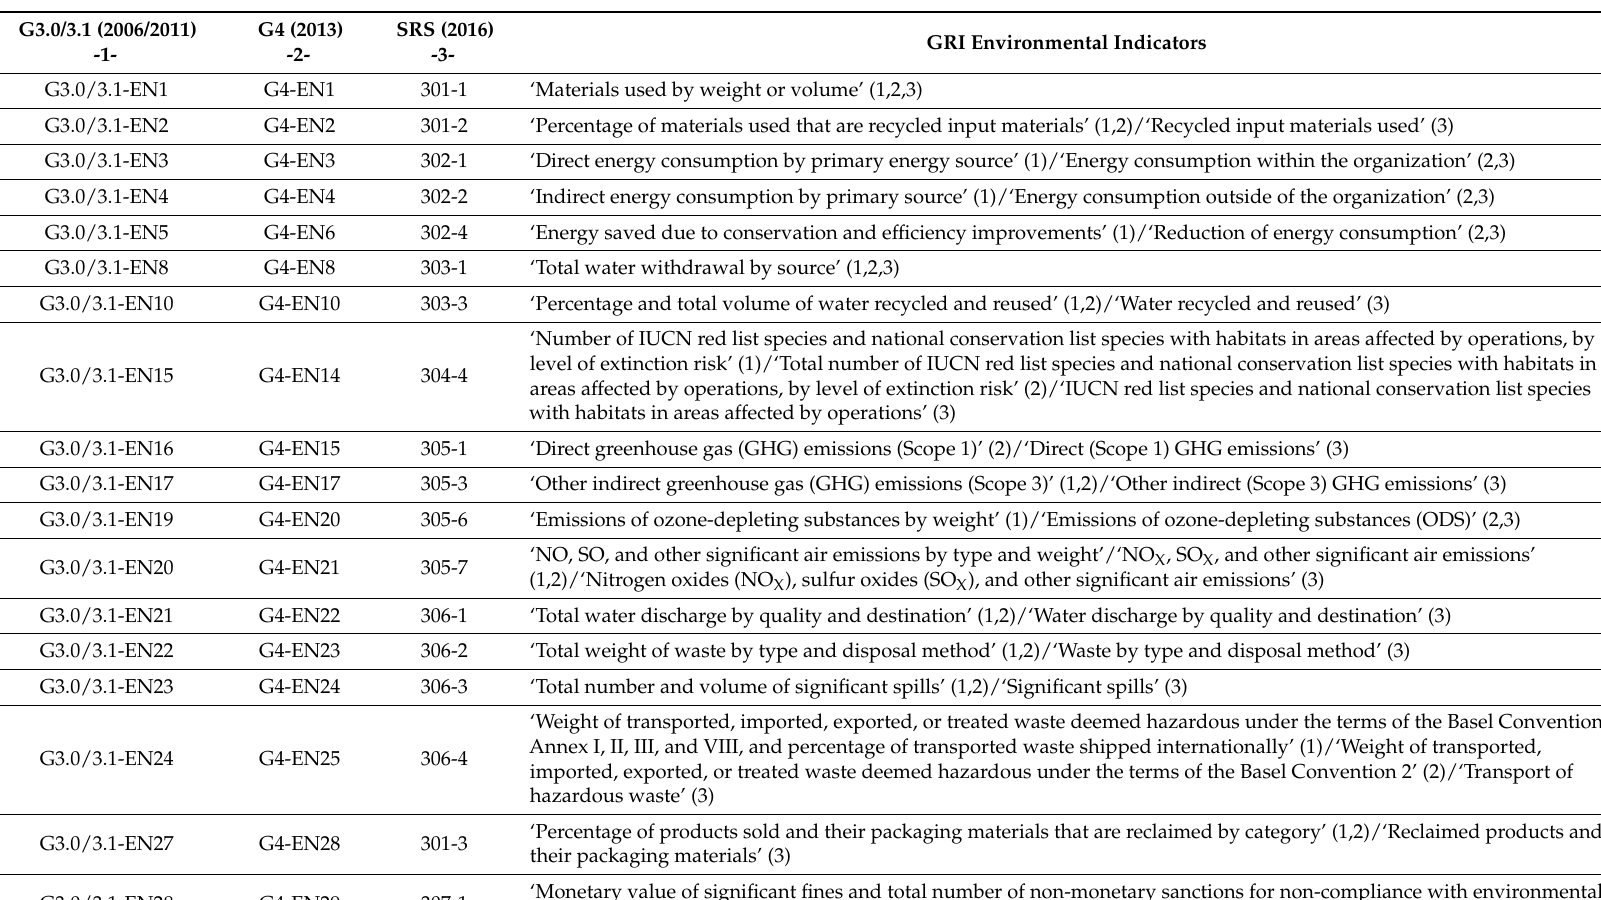
Table A2. Comparative Analysis of Environmental